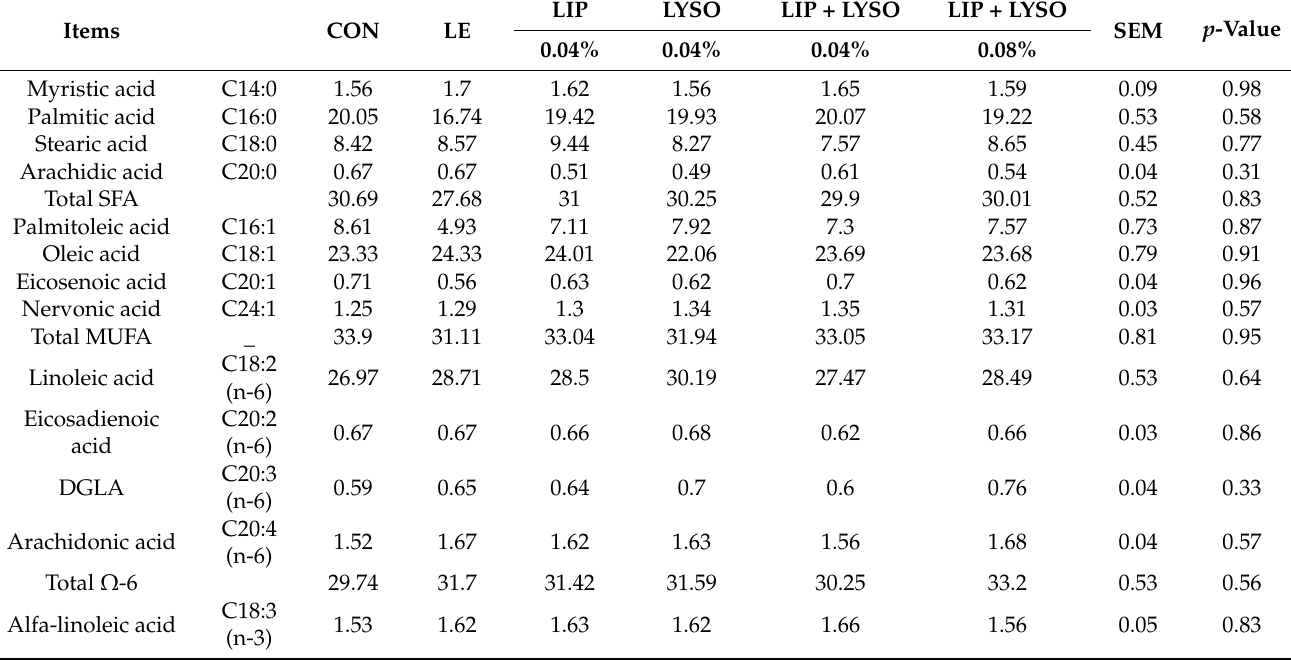
Table 6. Effect of low energy diets and supplementation of emulsifier and lipase on the fatty acid profile of breast muscles in